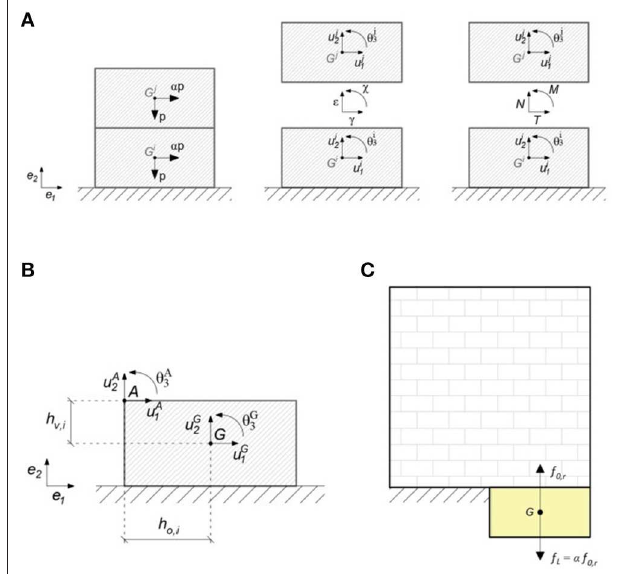
FIGURE 1 | (A) Simple two-blocks structure (B) Displacement components for a rigid block (C) Model for settlement: panel with fictitious block.